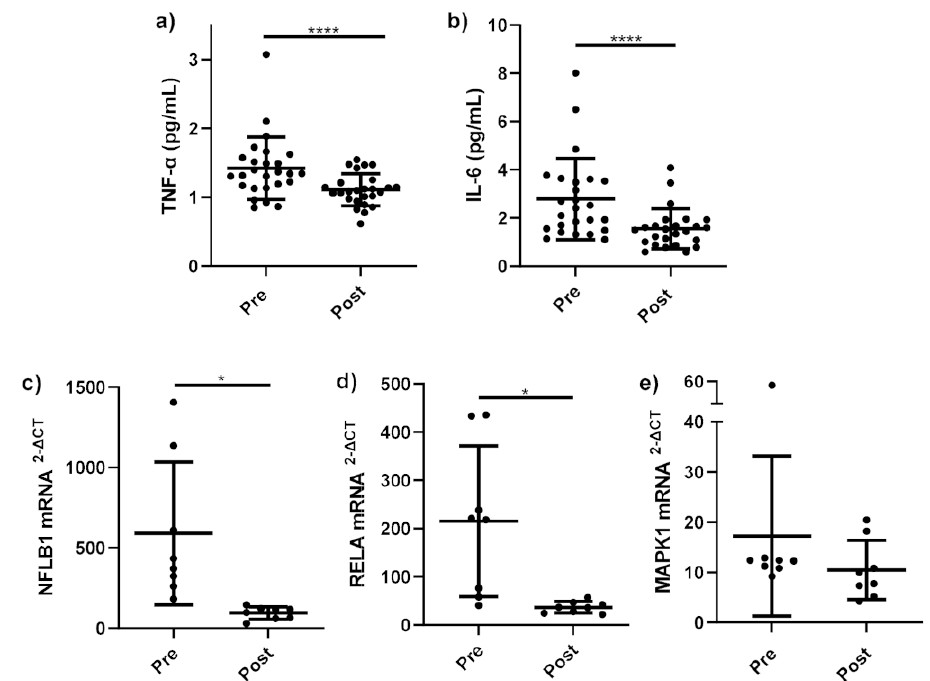
Figure 2. Pro-inflammatory cytokines and gene expression before and after bariatric surgery. Serum pro-inflammatory cytokines ( a ) TNF- α (pg/mL) ( n = 25); ( b ) IL-6 (pg/mL) ( n = 25) and mRNA expres- sion of ( c ) NF κ B1 ( n = 8), ( d ) RELA ( n = 8), and ( e ) MAPK1 ( n = 8) in monocytes stimulated with LPS (1 ng/mL) and incubated for 15 h, measured before bariatric surgery (Pre) and 12–18 months follow up (Post). Parametric data analysed by RM one-way ANOVA and post hoc analysis Tukey’s multiple comparison test, non-parametric by the Friedman test and post hoc analysis by Dunn’s multiple comparison test. TNF- α : tumour necrosis factor-alpha, IL-6; interleukin 6, Pre (pre-operative), Post (12–18 months follow up), LPS; lipopolysaccharide. * p < 0.05, **** p < 0.0001. Data presented as the mean